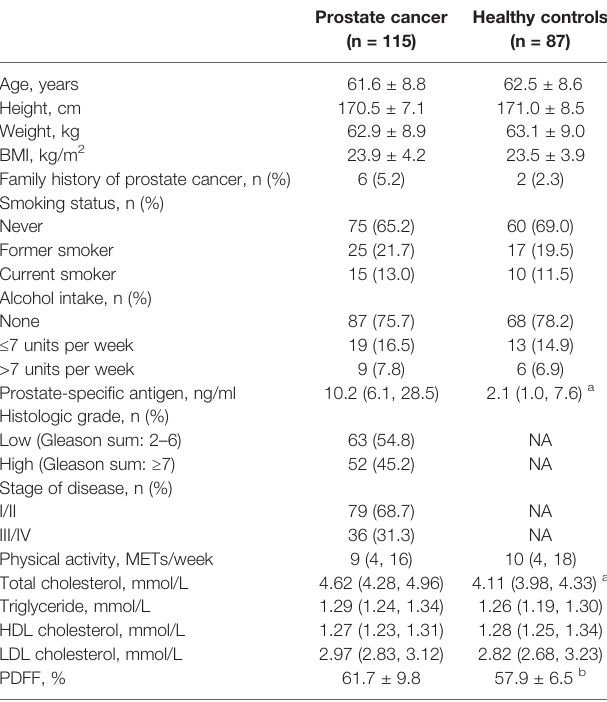
TABLE 1 | Baseline characteristics of the study population.